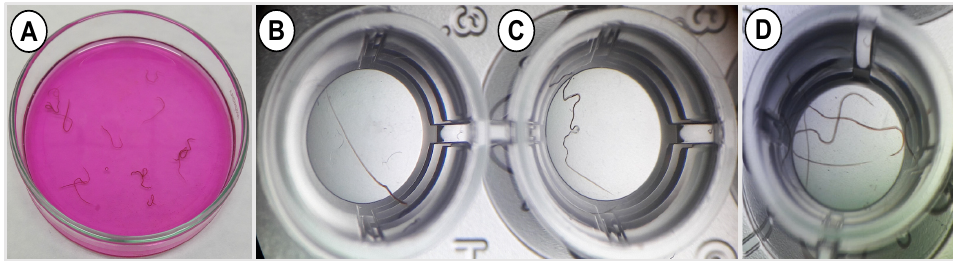
Figure 14. Adult worm motility assay showing worms treated with CS-PLGA particles encapsu- lating combined EO components. ( A ) H. contortus worms exposed to 10 μ g/mL. 4x magnification. ( B – D ) T. axei worms exposed to 10, 5, and 2.5 μ g/mL, respectively. 40x magnification.